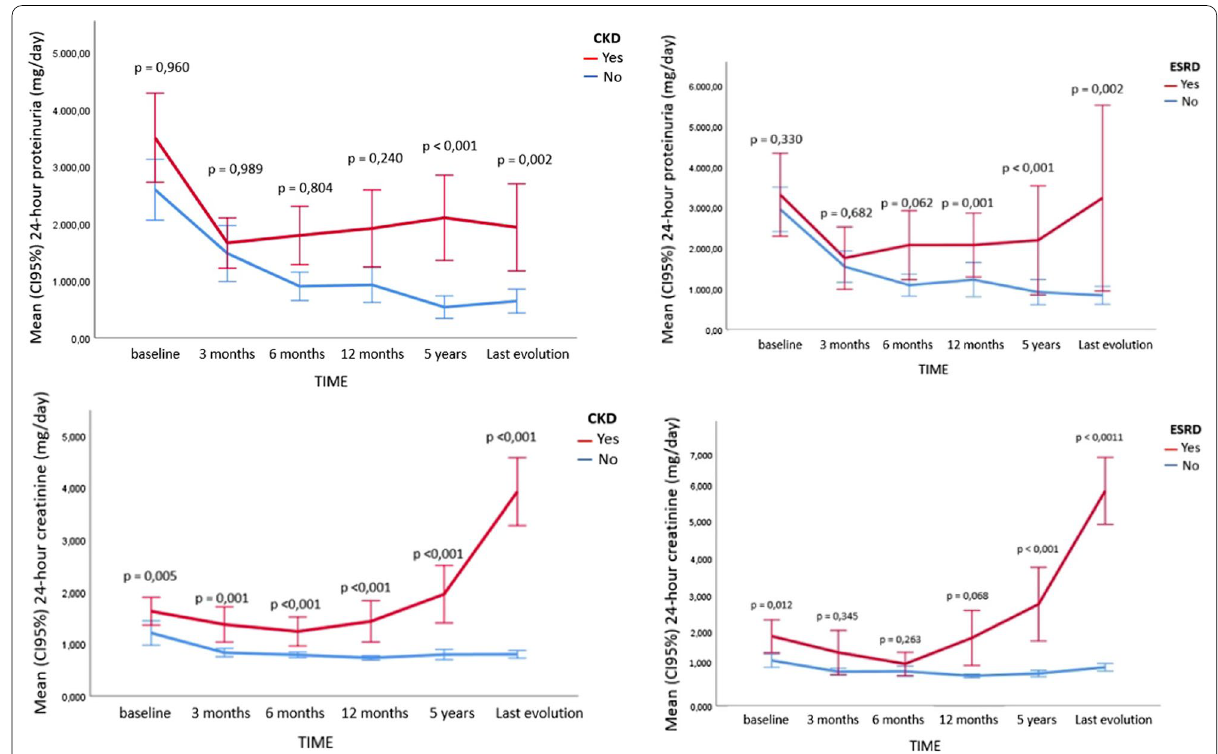
Fig. 1 24-h proteinuria (g/day) and serum creatinine (mg/dL) during follow-up in patients with LN who developed chronic kidney disease